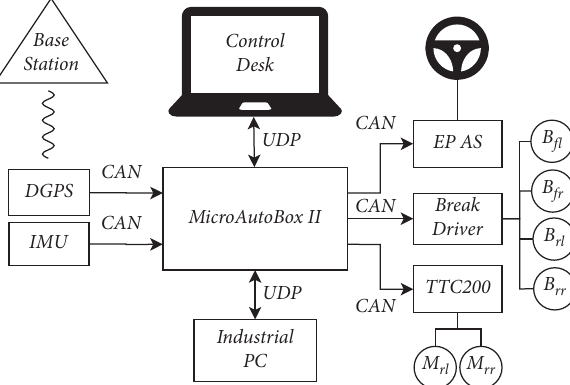
Figure 8: Measurement setup of the real-time